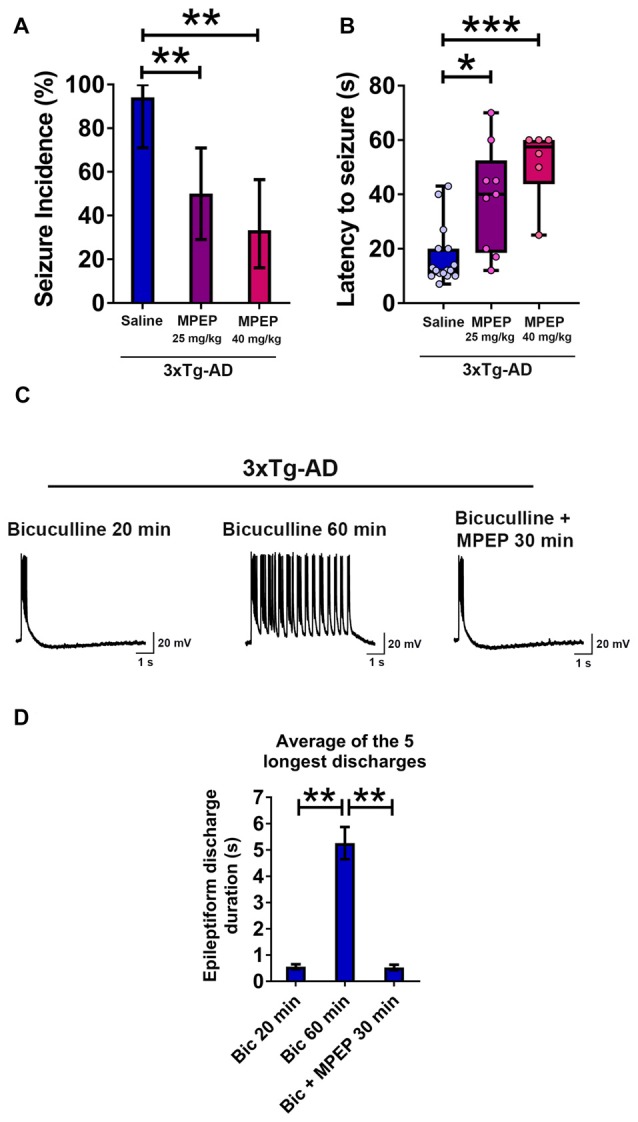
Suppression of seizure susceptibility and prolonged epileptiform discharges in hippocampal slices of 3-week-old 3xTg-AD mice by the metabotropic glutamate receptor 5 (mGluR5) antagonist 2-methyl-6-(phenylethynyl)pyridine hydrochloride (MPEP). (A) The incidence of convulsive seizures was significantly reduced in a dose dependent manner by intraperitoneal (i.p.) injection of MPEP at 25 mg/kg or 40 mg/kg, half an hour prior to audiogenic stimulation, compared to a saline injected group. The data are presented as percent incidence with 95% confidence interval and compared using exact logistic regression stratified by litter. (B) The data are depicted as box and whisker plots (median with interquartile range, and upper and lower extremes) and analyzed using Kruskal-Wallis test followed by Dunn’s multiple comparison test. The data shown in (A,B) are based on the following groups: saline control, n = 17; MPEP 25 mg/kg, n = 18; and MPEP 40 mg/kg, n = 18. (C,D) Prolonged epileptiform discharges in hippocampal CA3 pyramidal neurons of slices from 3-week-old 3xTg-AD mice recorded at 60 min after bicuculline perfusion were suppressed by MPEP (50 μM). Data are presented as mean ± SEM of the five longest epileptiform discharges from n = 9 slices from n = 5 mice, and compared using two-way ANOVA followed by Bonferroni post hoc test. *p < 0.05, **p < 0.01, ***p < 0.001.